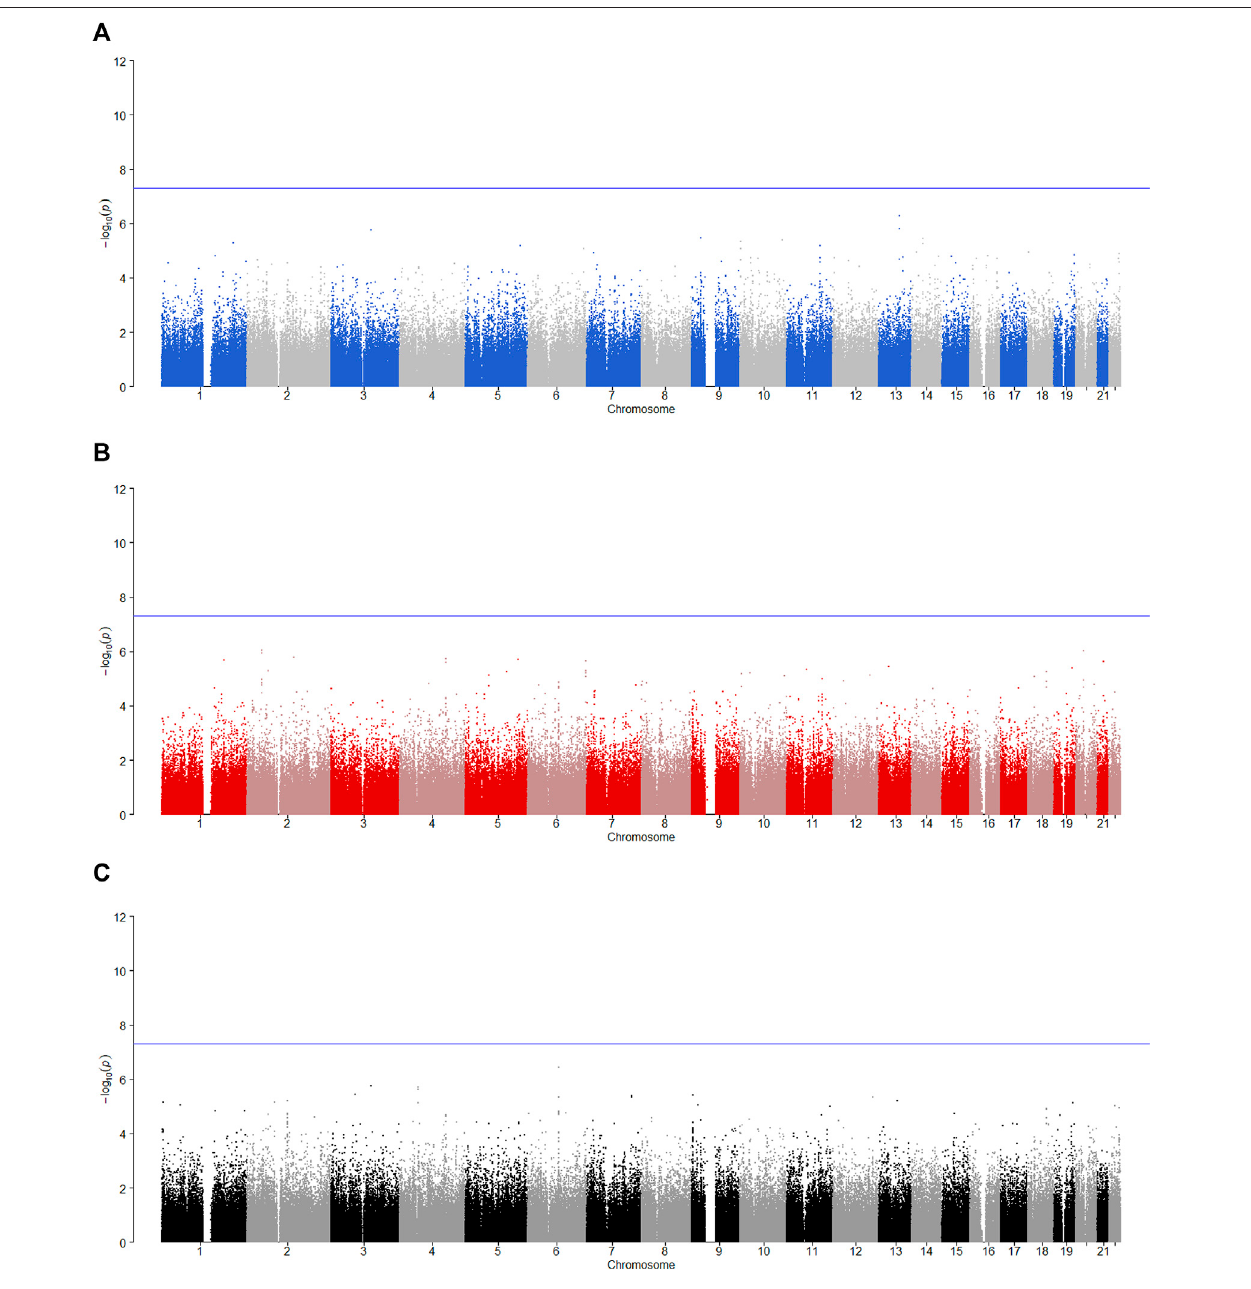
FIGURE 6 | Manhattan plot for POE and genotypic effect tests of non-substance use related behavioral disinhibition ( N = 2,185). The blue line represents the signi fi cance level α (cid:1) 5 × 10 − 8 , which is the signi fi cance level of GWAS. (A) Paternally derived effect, (B) maternally derived effect and (C) genotypic effect.